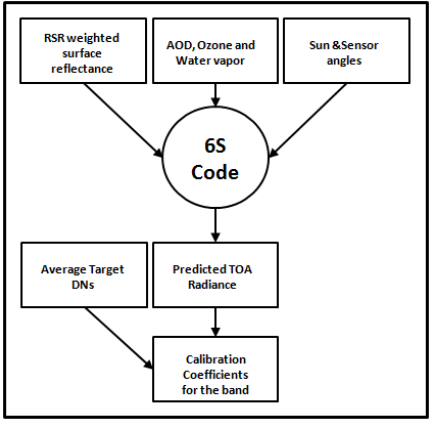
Figure 13. Reflectance based absolute radiometric calibration flow chart.